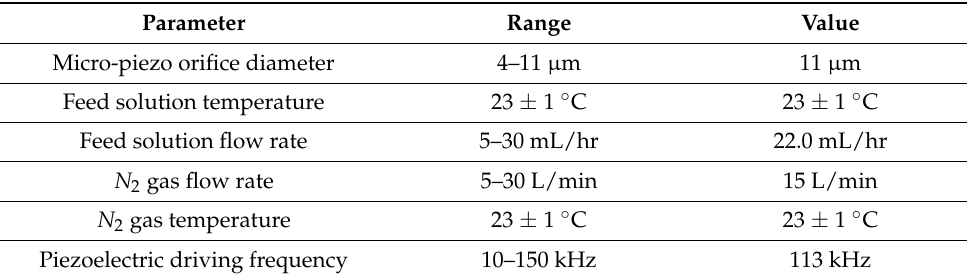
Table 1. The range and optimized TTMD operation parameters for particle